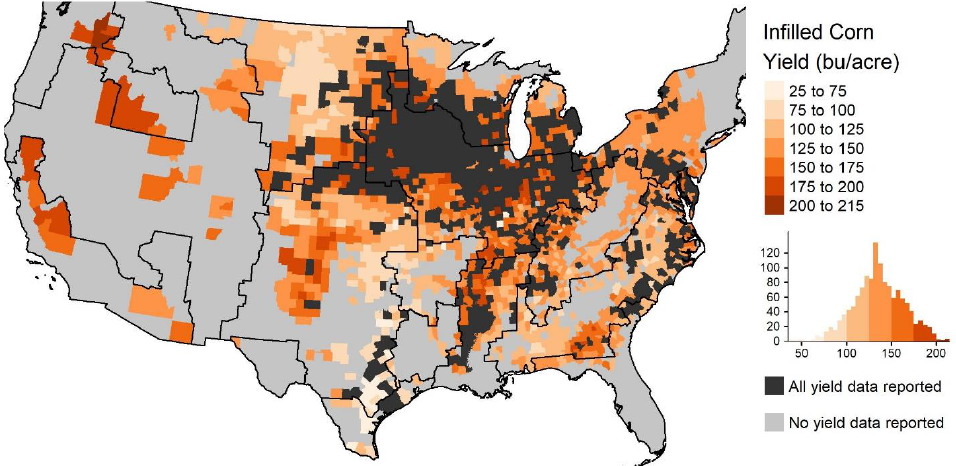
Figure 5. Average corn yield in predicted infilled dataset in the reduced ensembles. Note: 1048 counties in light gray, are counties where n = 0 years of reported yield and were excluded from the infilling process, as per Figure 1, above. The remaining 745 counties marked in dark gray are those in which no infilling was necessary (e.g., in the Corn Belt, where NASS reports corn yield data each